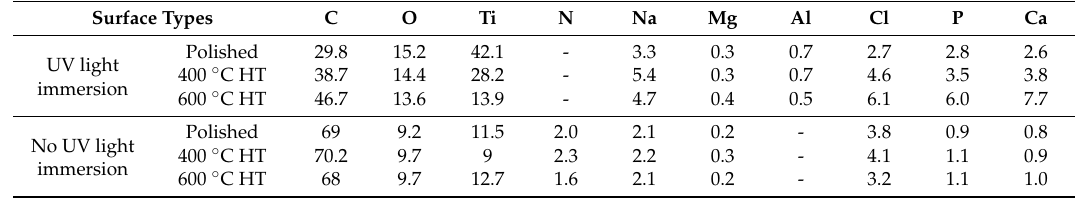
Table 1. Composition of the surfaces after immersion in simulated body fluid (+0.8 g/L bovine serum album) detected by Energy-dispersive X-ray spectrometer (at